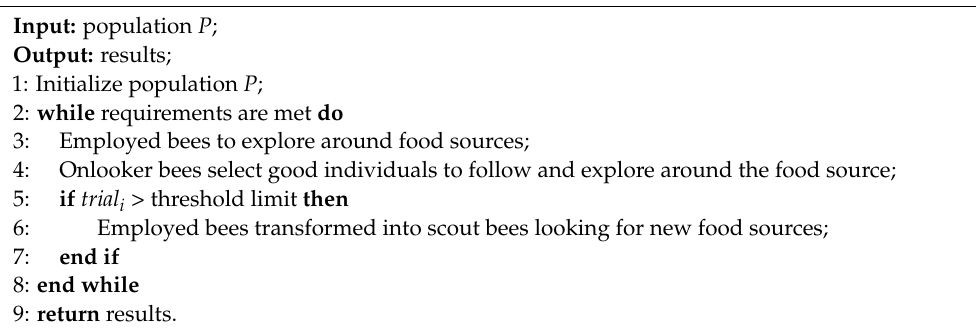
Algorithm 1 Framework of the basic ABC